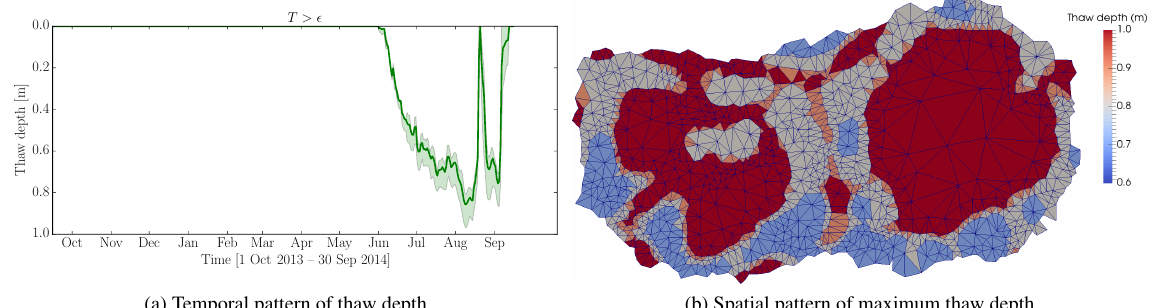
Figure 13. Temporal (left panels) patterns of simulated thaw depths (defined as thickness of soil layers above 0 ◦ C) and spatial pattern of maximum thaw depth (right panels) at Site A. The bold line represents the mean thaw depth across the site, while the shaded curve represents standard